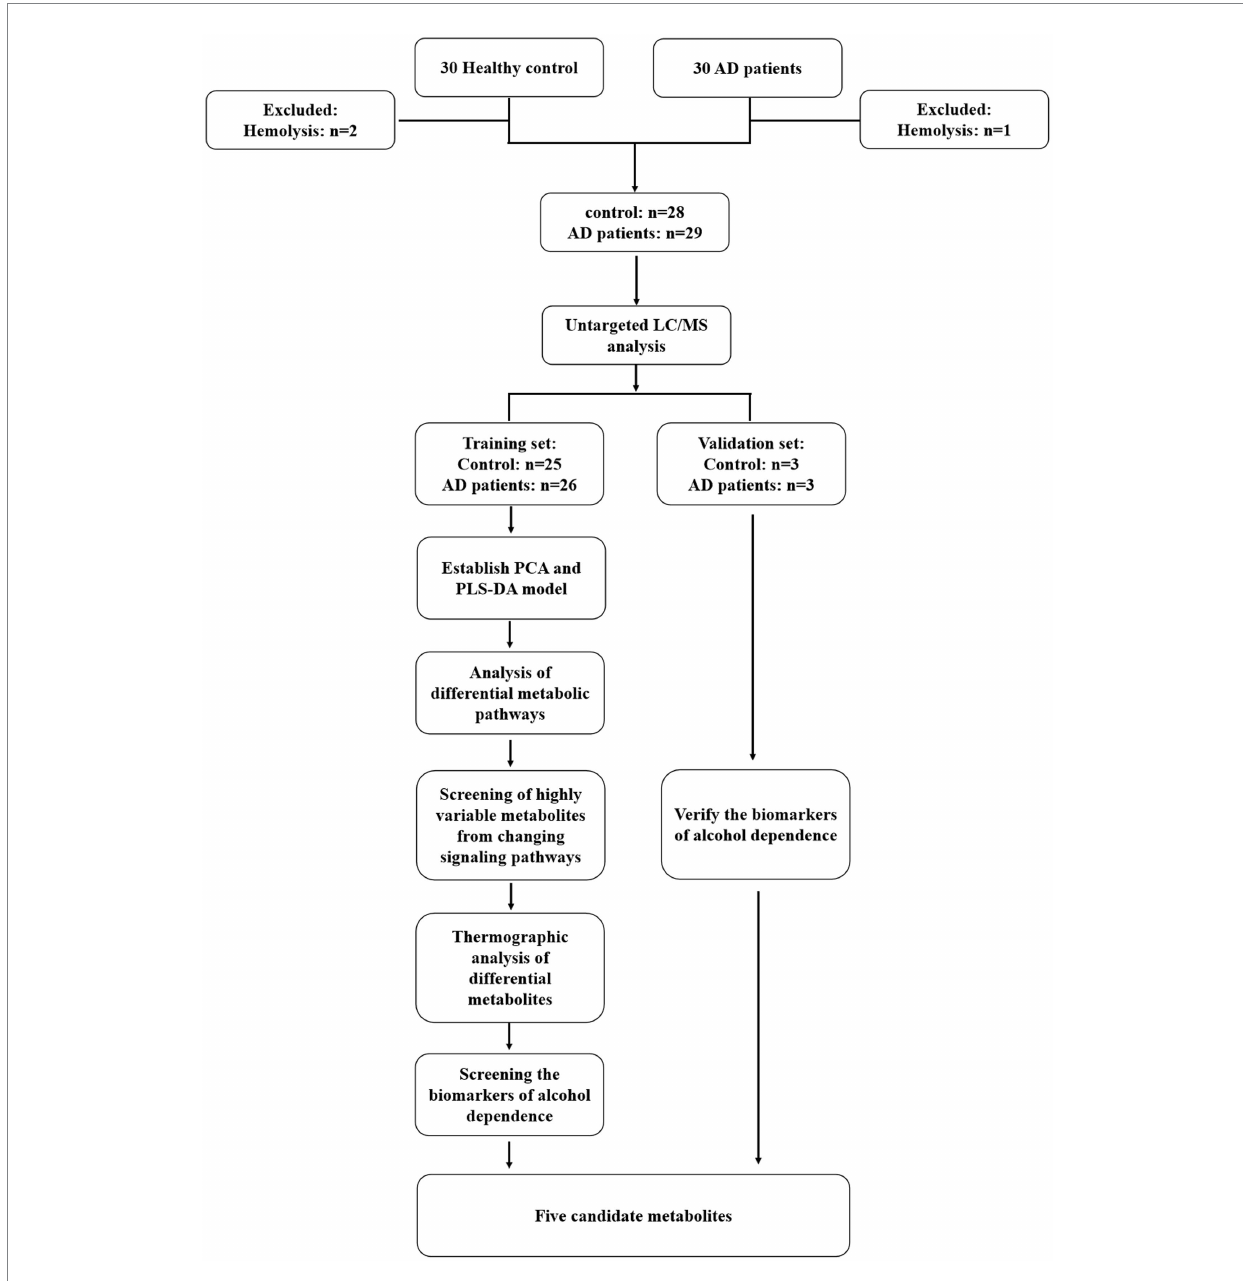
FIGURE 1 The flowchart of the study